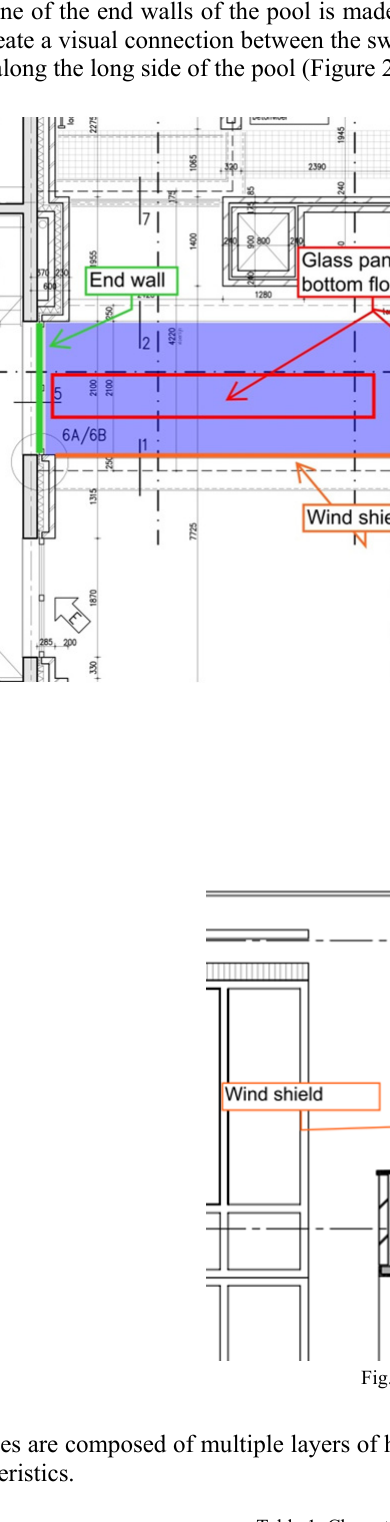
Table 1: Characteristics of the heat strengthened glass